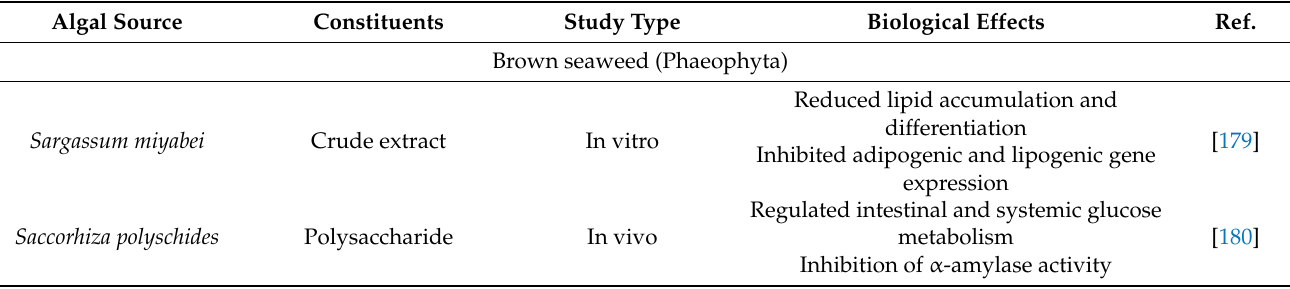
Table 5. The effects of seaweed-derived compounds on